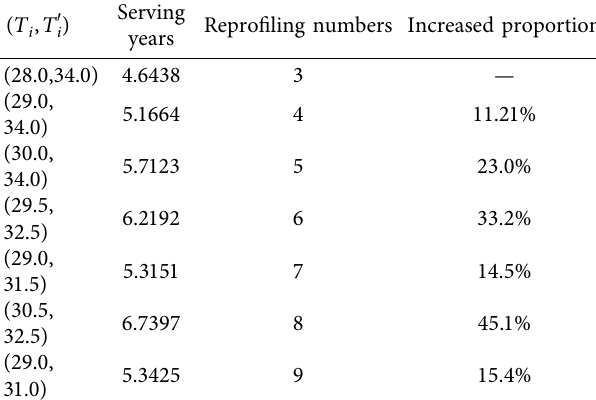
Figure 9: Results of the fixed reprofiling strategy: (a) strategy; (b) reprofiling numbers; (c) using years. Table 2: Details of several preferable